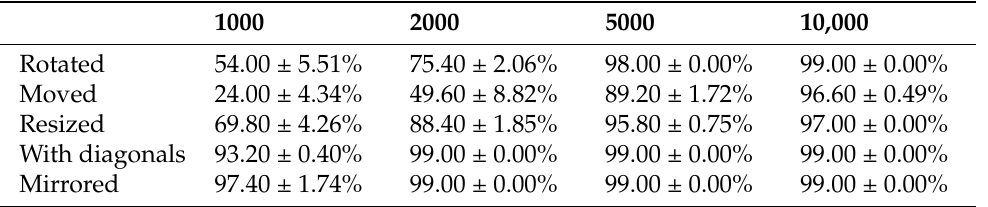
Table 13. The number of transformed objects: 10; Level of noise: